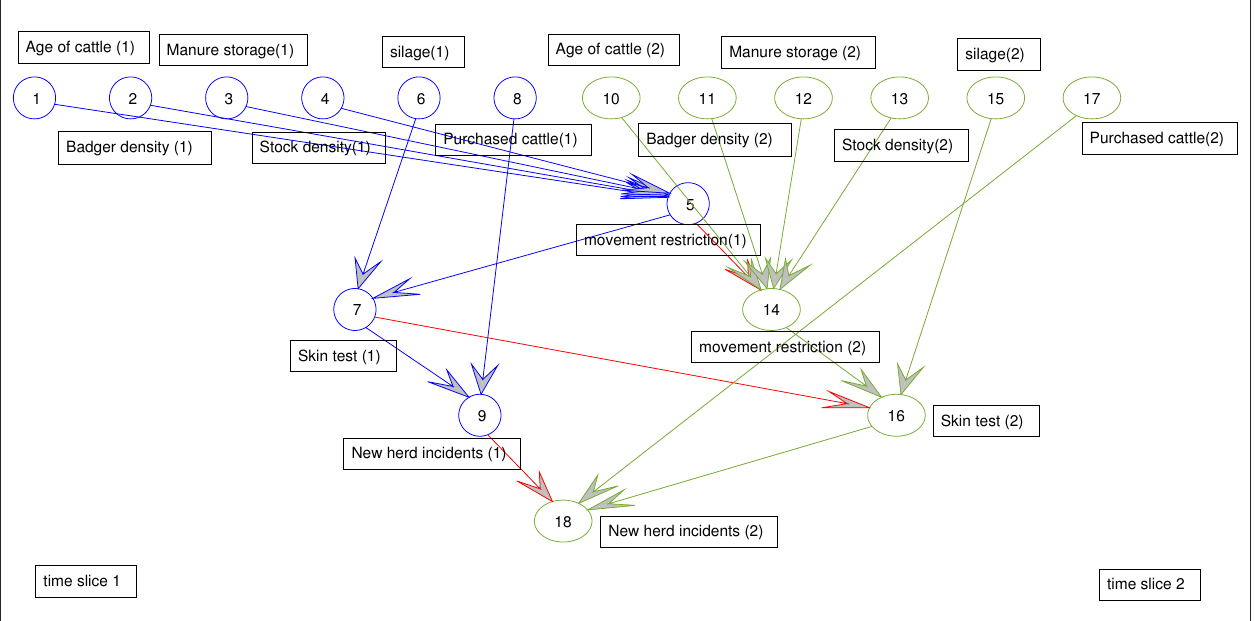
Figure 4. Dynamic Bayesian network model. In this figure, cycles over time can be represented for Figure 3, using an underlying acyclic DBN. In this DBN, skin test results at time t influences the skin test results at time t +